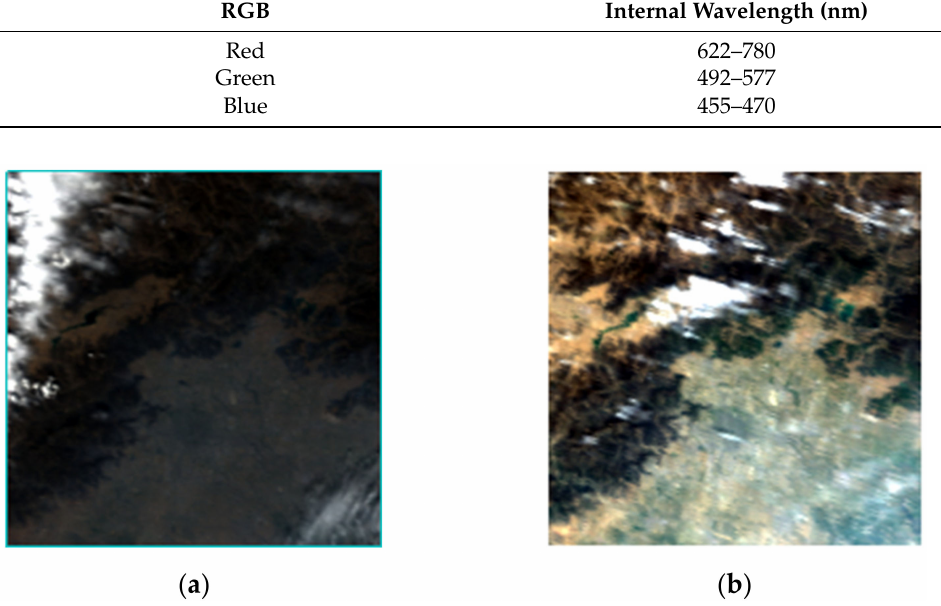
Figure 4. ( a ) is the satellite image with full channel information, and ( b ) is the synthesized RGB